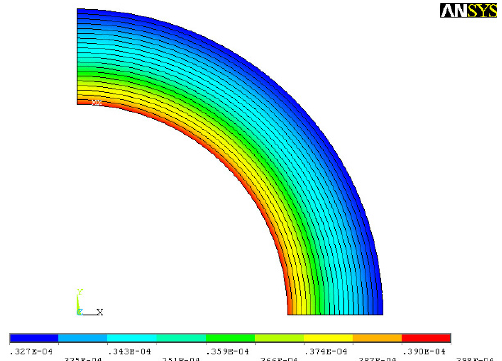
Figure 11. Radial displacement obtained from ANSYS code in an FGM disk ( ξ = 1 . 5 , η = 3)